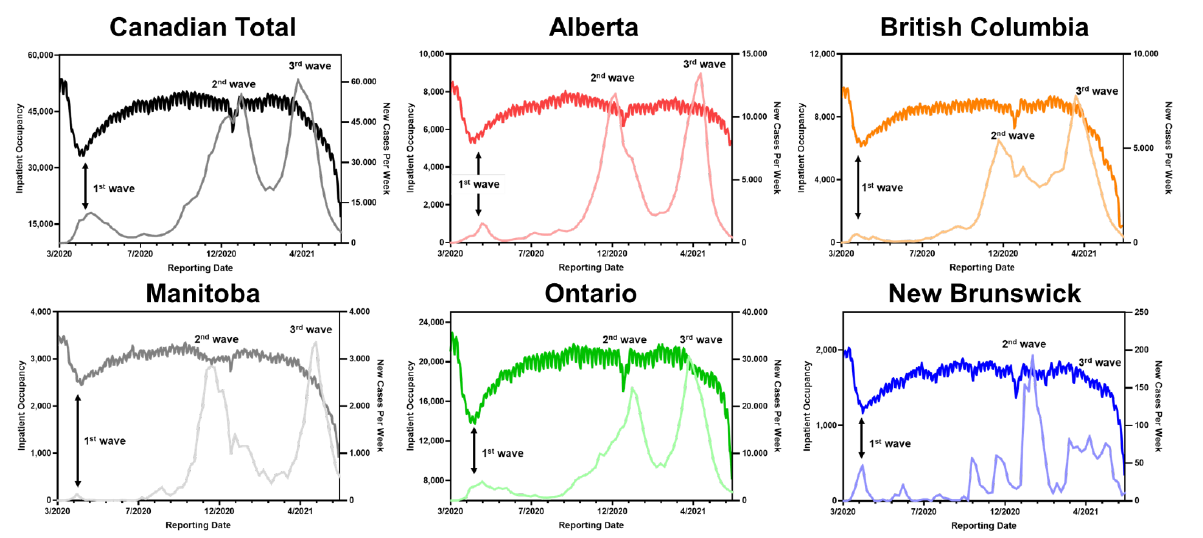
Figure 2. Hospital inpatient occupancy and confirmed COVID-19 cases per week, showing a correlation. Arrows indicate “COVID-19 waves”, the periods of surges in confirmed COVID-19 cases. Left axis: hospital occupancy. Right axis: confirmed new cases.